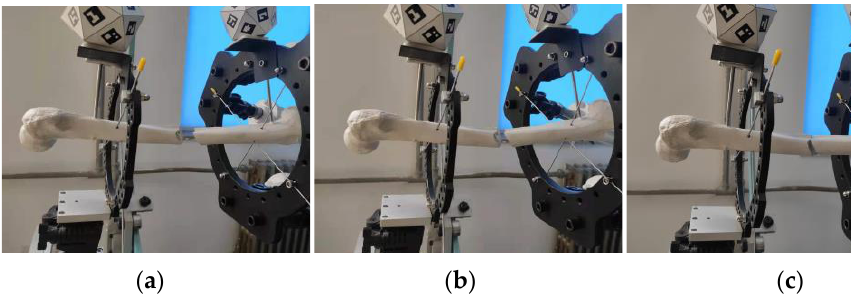
Figure 15. ( a – c ) are the process of FRR prototype.